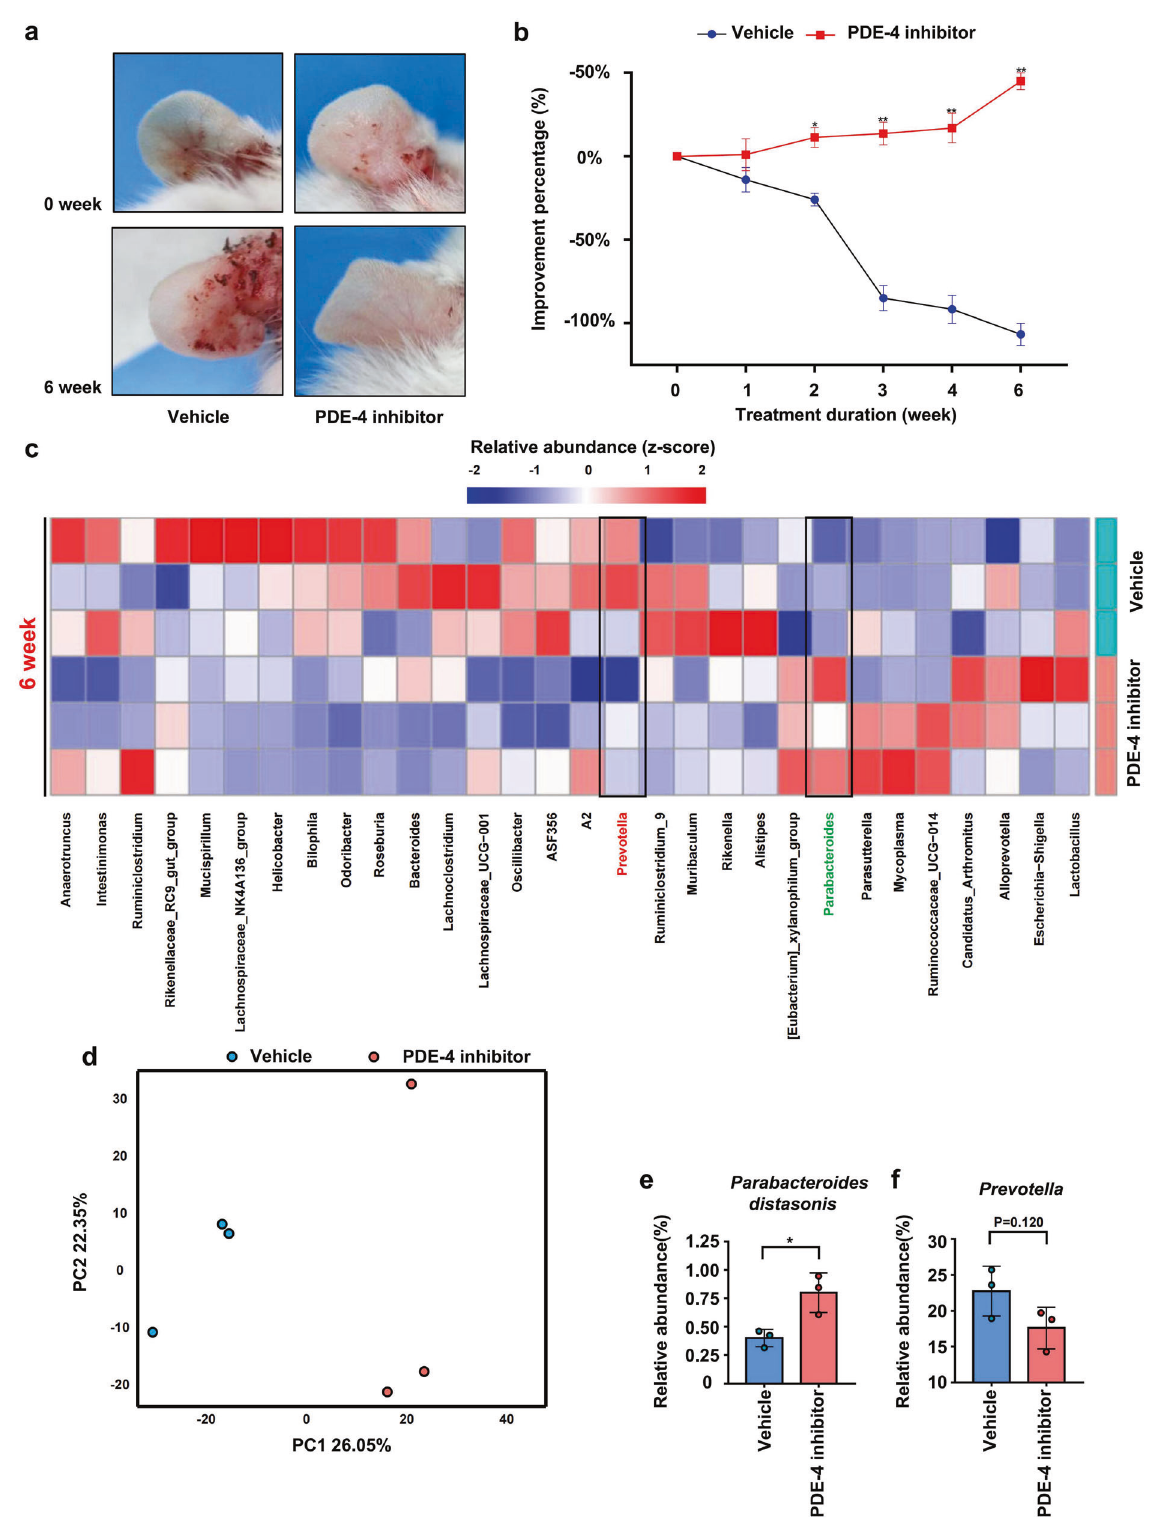
Fig. 8 The administration of PDE-4 inhibitors signi fi cantly improved psoriasis-like skin phenotype in K14-VEGF mice and was accompanied by recovery of intestinal microbiota. a Macroscopic characteristics of the ears in Vehicle and PDE-4 inhibitor group mice in 0 week and 6 weeks. b Improvement percentages of PASI score of ears in Vehicle and PDE-4 inhibitor group mice from 0 week to 6 weeks. c Taxonomic distributions of bacteria. d PcoA of unweighted UniFrac distance based on 16s rDNA pro fi ling of feces from Vehicle and PDE-4 inhibitor group mice. e , f Relative abundance of Parabacteroides distasonis and Prevotella in the feces of Vehicle and PDE-4 inhibitor group mice. Data presented as mean ± SD on relevant graphs. * P ≤ 0.05; ** P ≤ 0.01; *** P ≤ 0.005 (two-tailed Student ’ s t -test) ( n = 3)